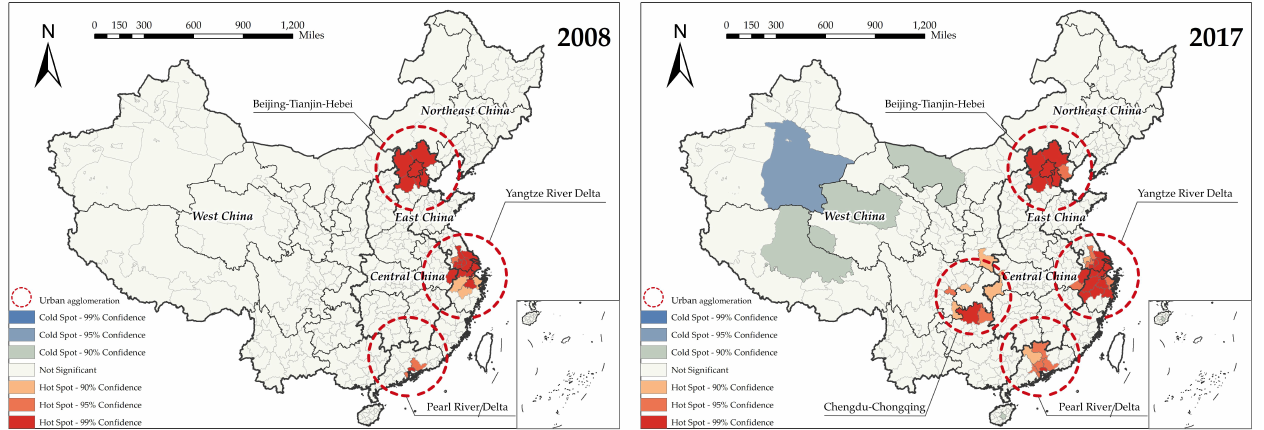
Figure 7. The urban agglomeration of the tourism industry across Chinese cities in 2008 and 2017: hot spot mapping for the areas’ total tourism revenue, estimated by the optimal Bayesian STVC